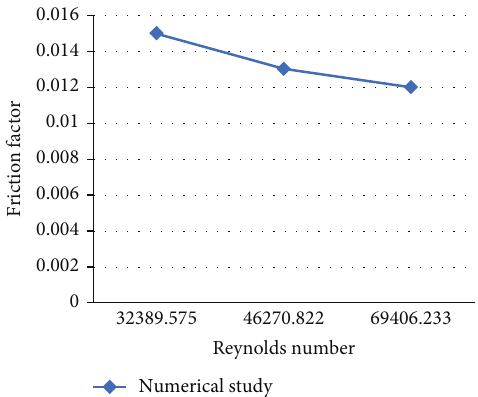
Figure 12: Nusselt number – Peclet number relationship for 1% alumina.